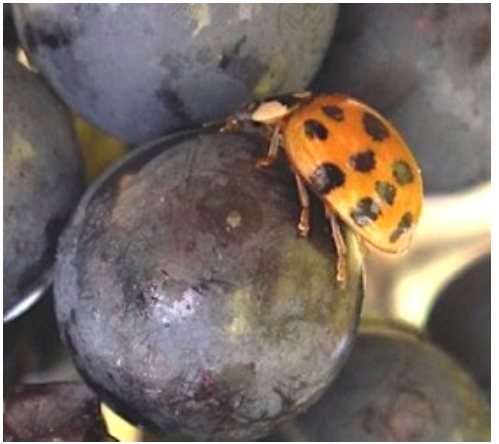
Figure 1. A Harmonia axyridis (MALB) beetle on a grape berry prior to harvest.